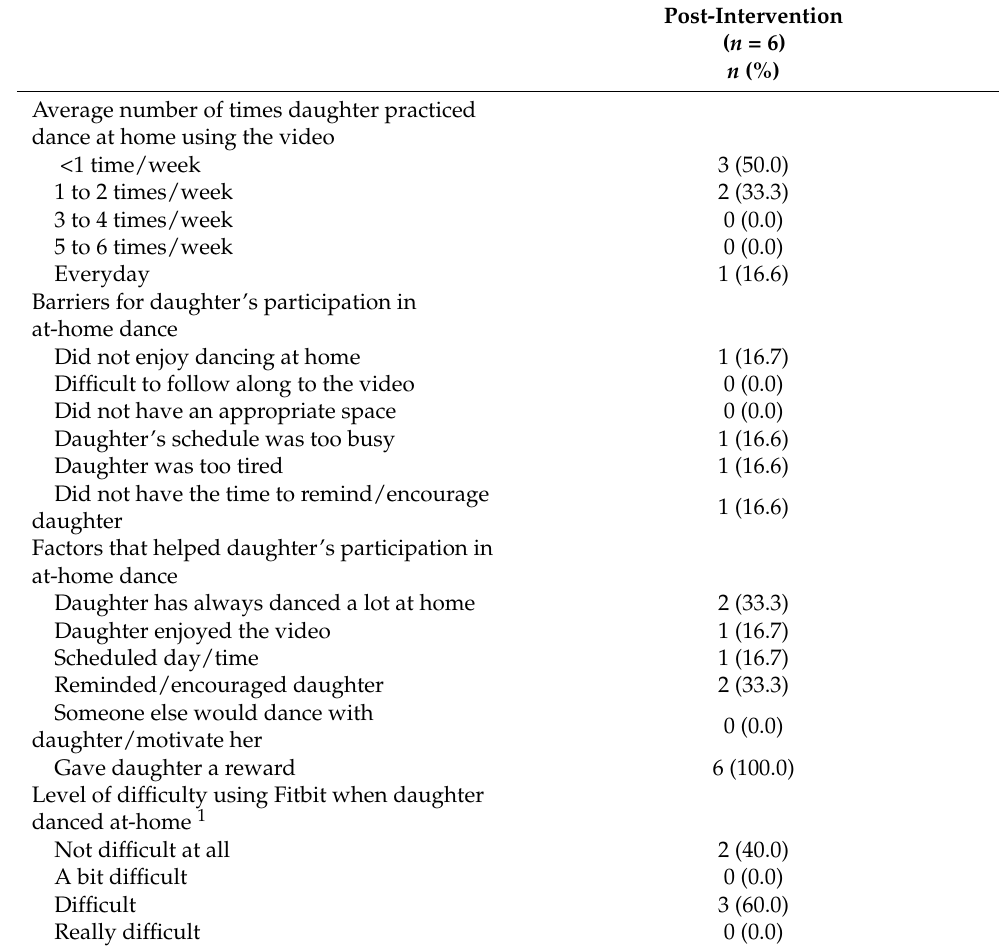
Table 6. Parent perceptions of the at-home dance videos and Fitbit monitors post- intervention at site B